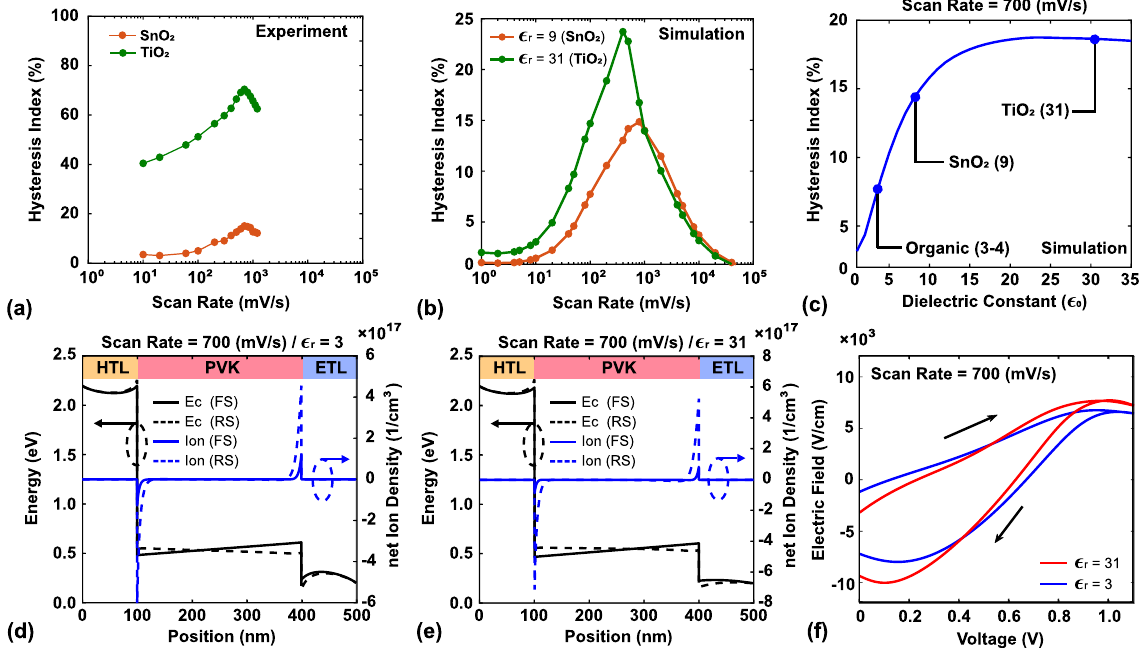
Figure 4. ( a ) HI values at different scan rates for experiments with ETL of SnO 2 and TiO 2 . ( b ) HI values at different scan rates for modeling results with the dielectric constants of 9 and 31. ( c ) HI values for different dielectric constants at the fixed scan rate of 700 mV / s . ( d , e ) Conduction band and net ion density distribution at the voltage of 0.6 V for dielectric constants of 3 and 31, respectively. ( f ) Electric field vs. voltage under forward and reverse